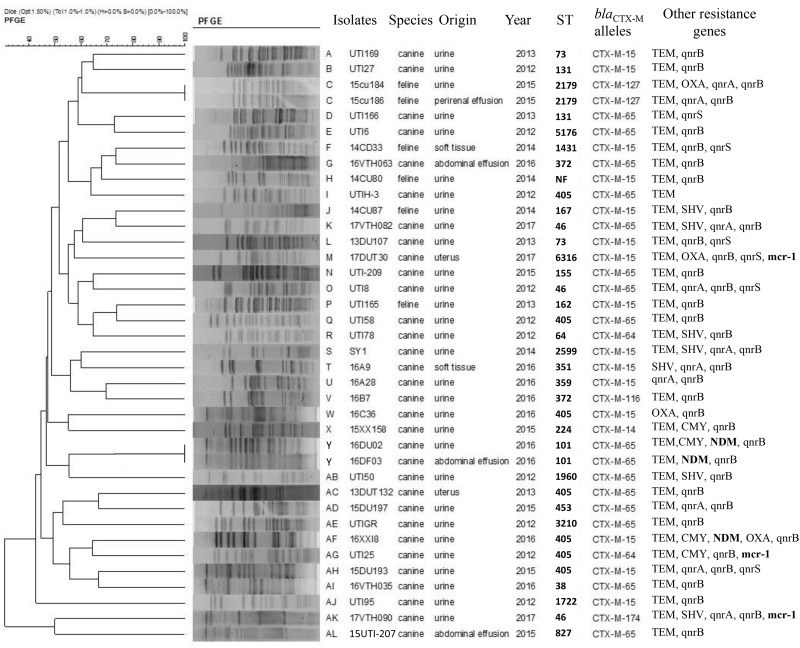
XbaI pulsed-field gel electrophoresis (PFGE) analysis of E. coli containing blaCTX variants.